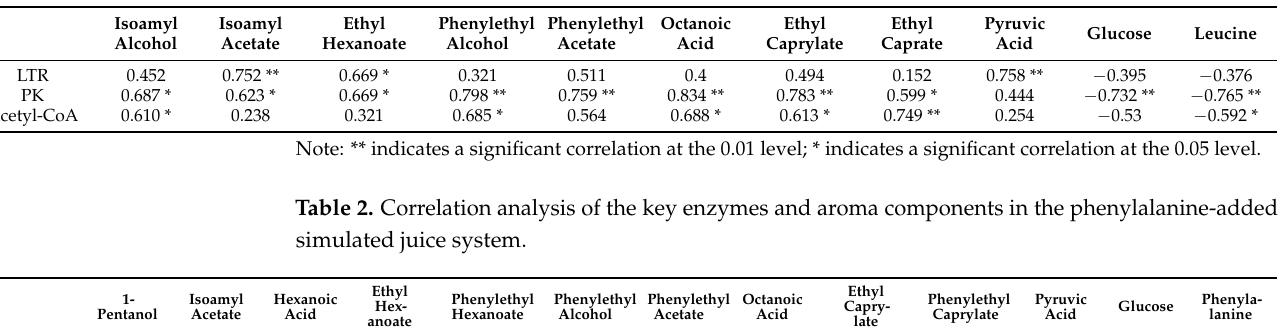
Table 1. Correlation analysis of the key enzymes and aroma components in the leucine-added simulated juice system.